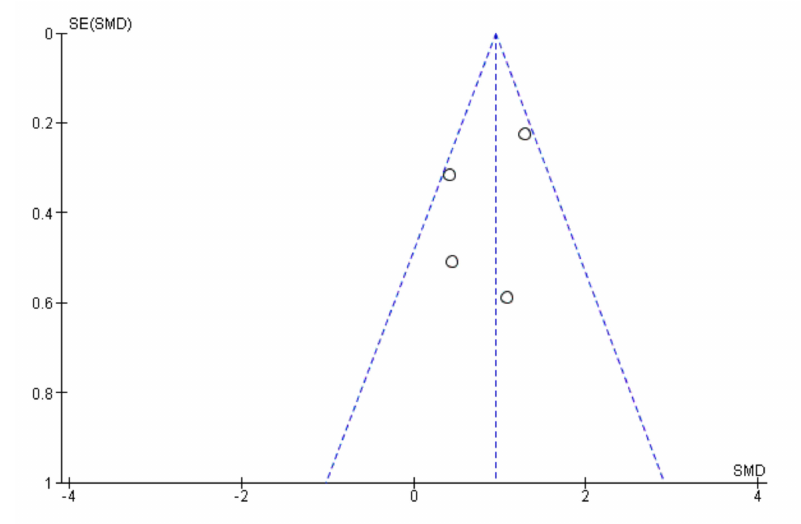
Figure A5. Funnel plot: fixed e ff ects meta-analysis for the e ff ect of VR on self-reported pain during dressing. Changes compared to